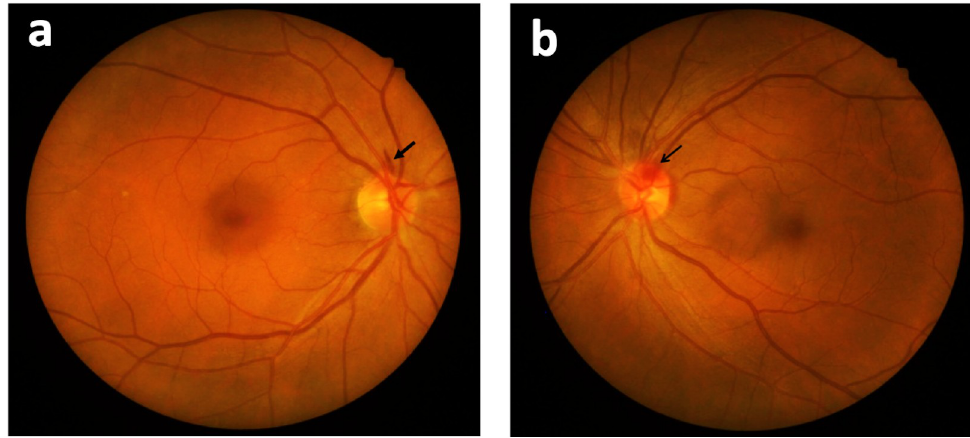
Fig 1. Two types of peripapillary DH. (a) A 64-year-old woman with flame-shaped peripapillary hemorrhage (arrow). (b) A 59-year-old woman with dot peripapillary hemorrhage (thin arrow).